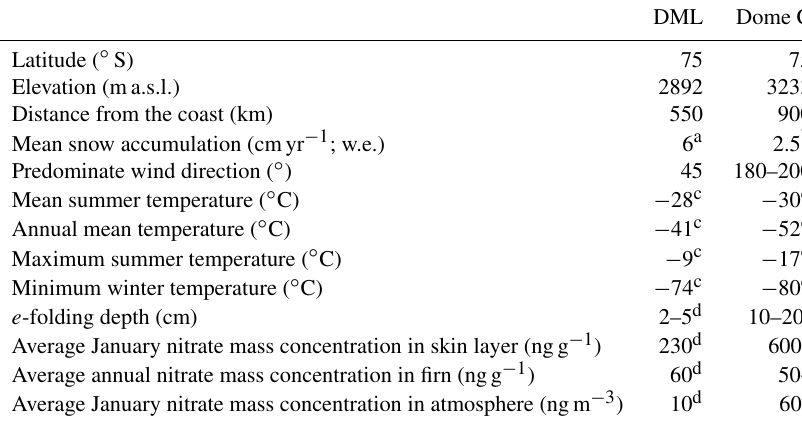
Figure 2. Map of ISOL-ICE ice core drilling and atmospheric campaign and ice core sites and Antarctica stations mentioned in this study. (a) Insert of Kohnen Station in Dronning Maud Land (DML) highlighting the predominate wind direction, deep EDML ice core site, and the ISOL-ICE (b) “ice core” and (c) “flux” sites. (b) ISOL-ICE “ice core site” showing ice core, firn core, and snow pit A locations. (c) ISOL- ICE “flux” site showing location of in situ atmospheric instruments, surface snow, snow pit, and aerosol sampling locations, and e -folding depth measurements. Table 1. Site characteristics of Dronning Maud Land (DML) and Dome C ice core sites.